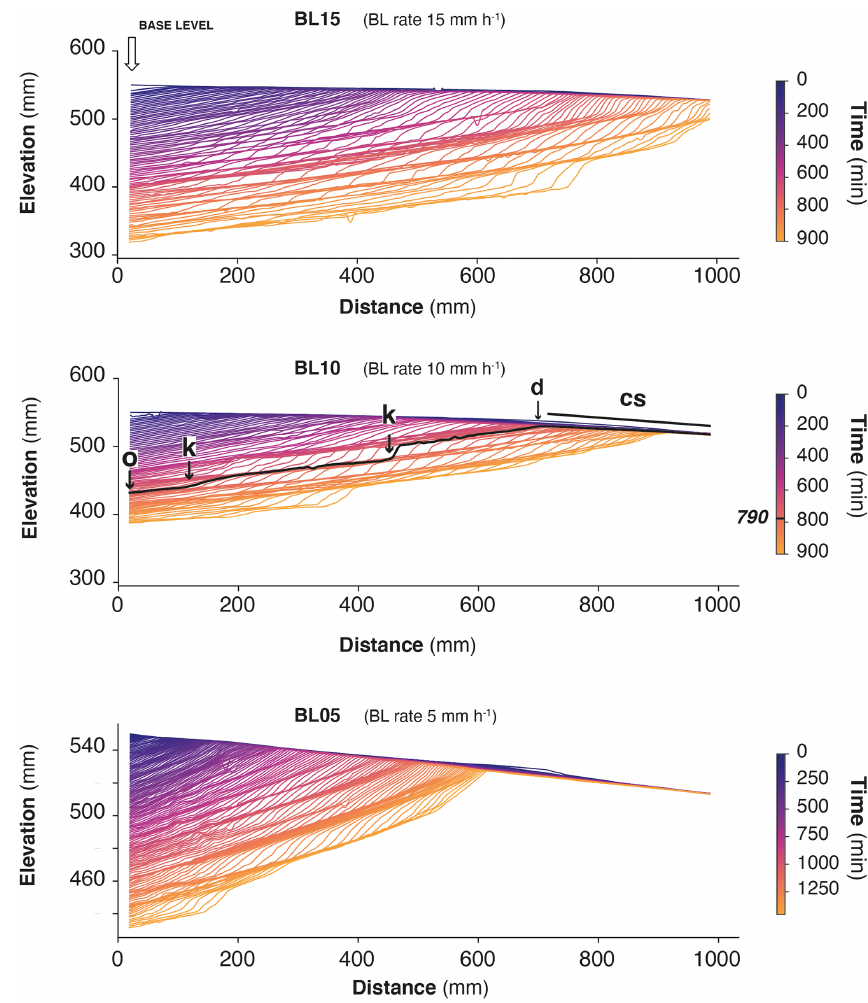
Figure 6. Successive river longitudinal profiles of experiments, shown here every 10min. Each longitudinal profile is colored according to experimental runtime. The sliding gate used to drop the base level is to the left. Note the initial counterslope (cs). Thick black line on BL10 is the longitudinal profile at t = 790min, illustrating the outlet (o), knickpoints (k) and water divide (d). Note the change in scale for experiment